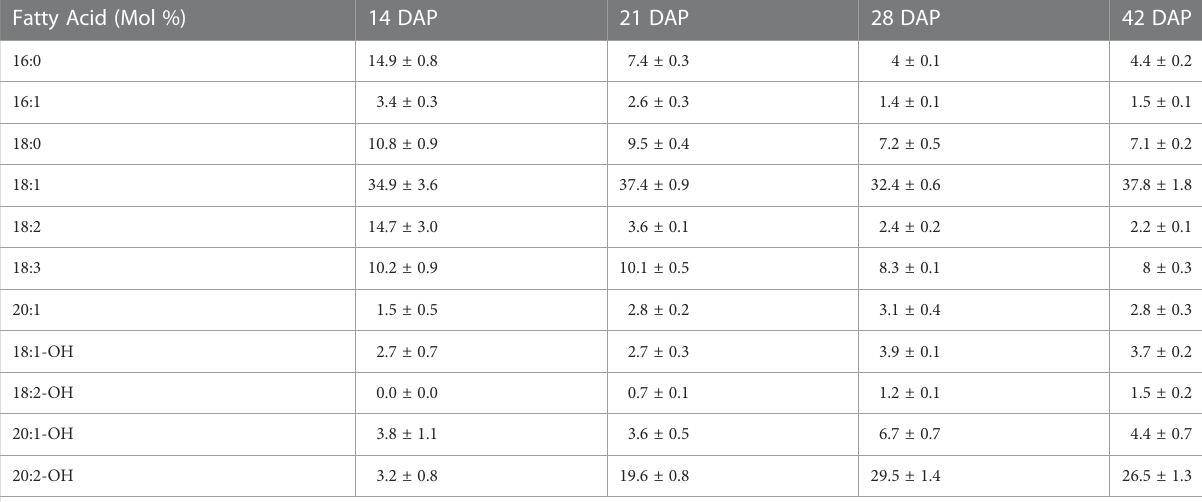
TABLE 1 The fatty acid composition of total lipid in developing seeds 14, 21, 28, and 42 days after pollination (DAP).